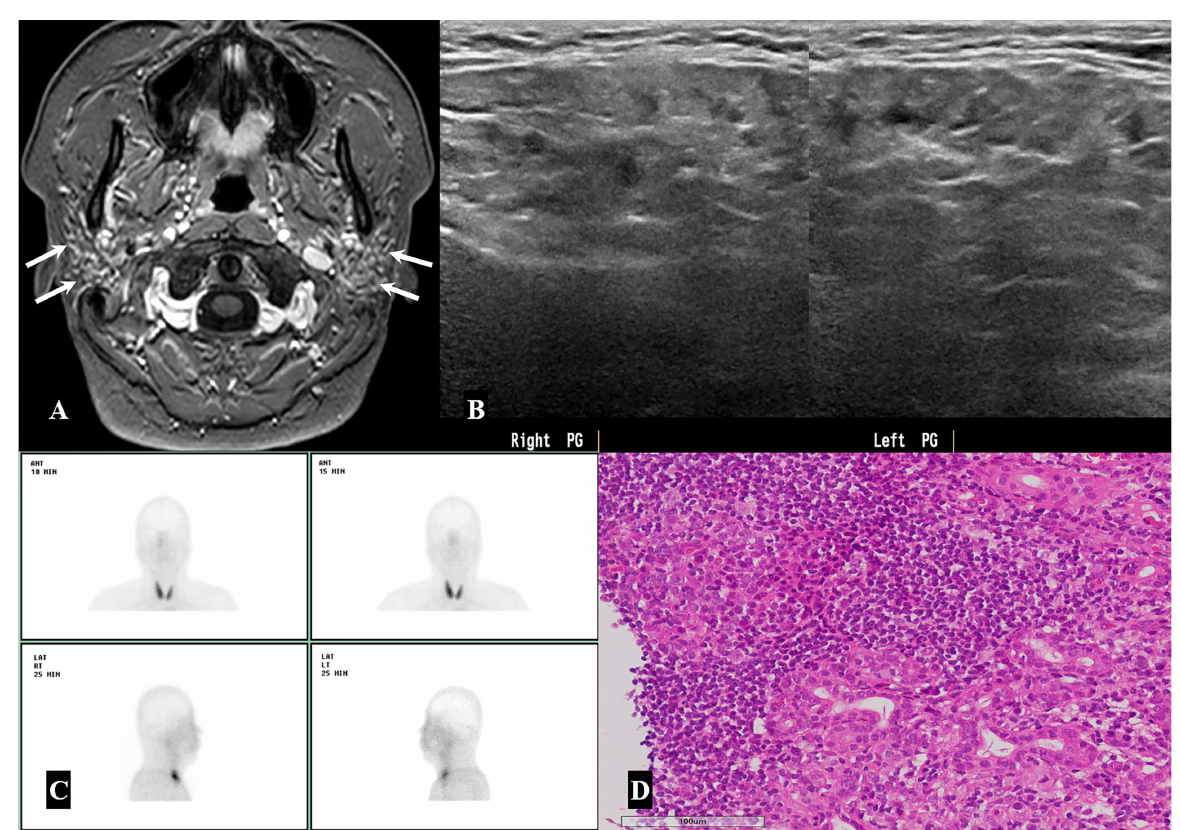
Figure 4. A 46-year-old woman with Sjögren’s syndrome. ( A,B ) On the contrast-enhanced axial T1-weighted image, there are multiple tiny enhancing granulonodular foci in both parotid glands with inhomogeneous parenchymal signal intensities. ( B ) On neck ultrasonography, the bilateral parotid glands show multiple tiny hypoechoic nodules with coarse parenchymal echotexture and decreased parenchymal echogenicity. ( C ) Salivary gland scintigraphy demonstrates severely decreased uptake in the bilateral parotid and submandibular glands. ( D ) Histopathological examination of ultrasound-guided core needle biopsy sample shows extensive lymphoid infiltration and interstitial fibrosis with a germinal center, suggestive of Sjögren’s syndrome ( × 200 magnification; hematoxylin and eosin